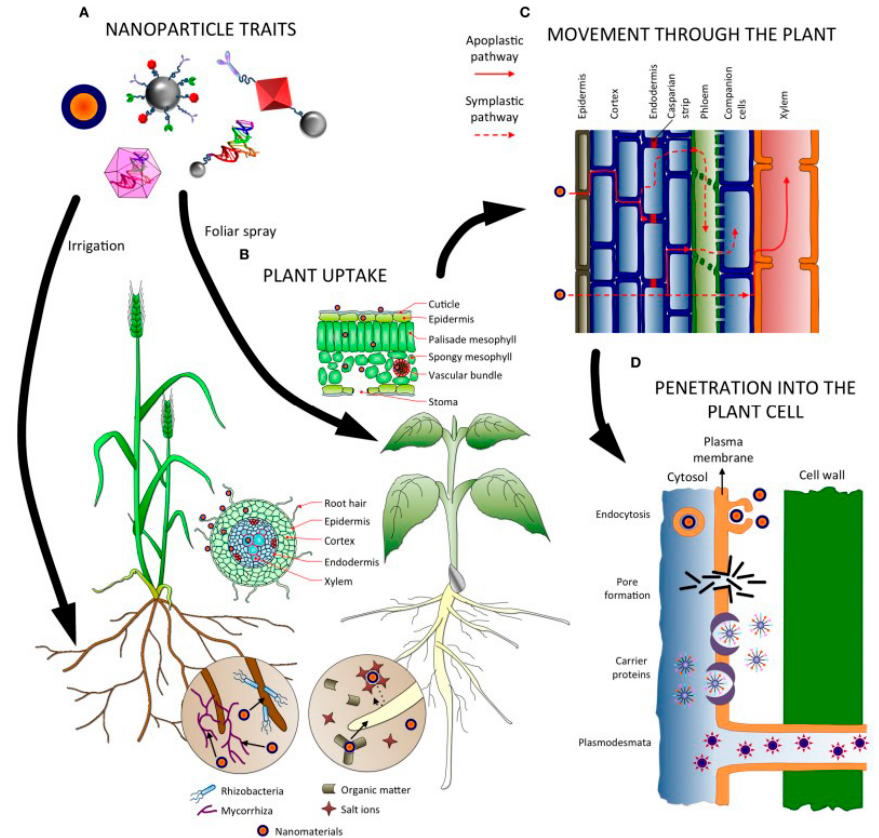
Figure 2. Schematic representation of the uptake mechanisms of NPs by plants. ( A ) Different composition effects of nanoparticles influence their uptake mechanism and their movement through plant tissues and cells. ( B ) Possible plant uptake pathways. ( C ) Two scenarios occur in which nanoparticles move through the plant (apoplastic and symplastic pathways). ( D ) Interaction of nanoparticles with plant cells for entering plasma membrane through pores. Reproduced from Ref. [27] under License CC BY Copyright (2017),